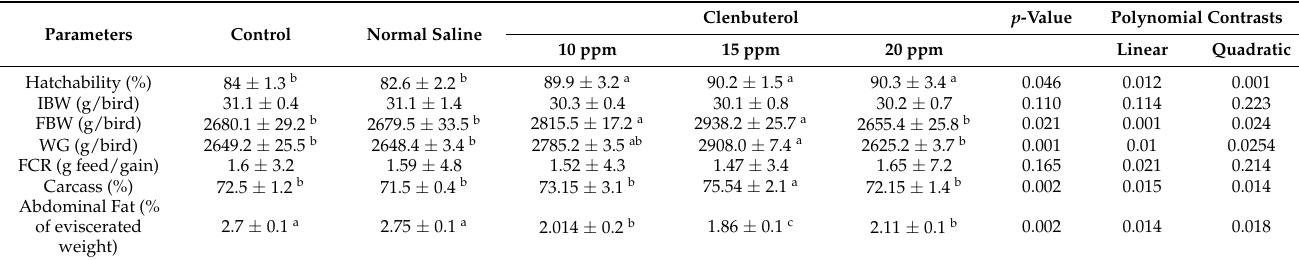
Table 3. Effect of in ovo feeding of clenbuterol on growth performance pattern of chicken.